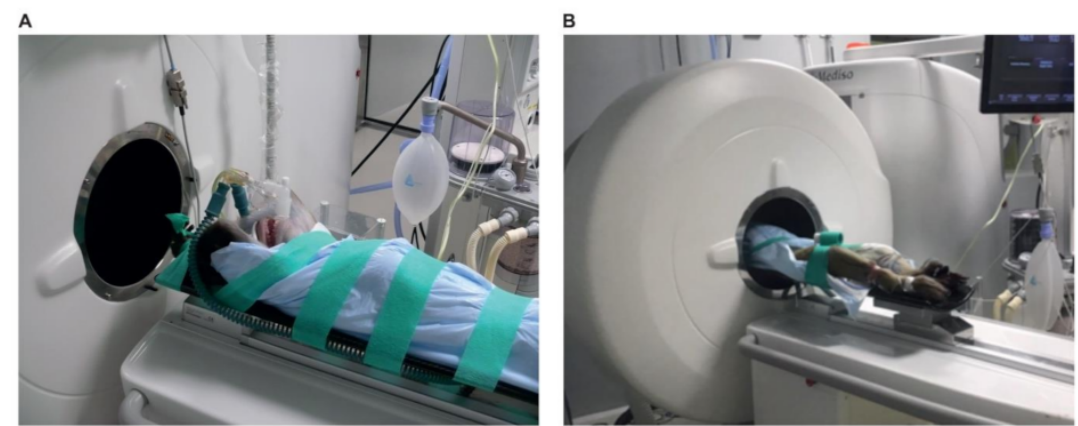
Figure 4. Visualization of the position of the animal on the scanner bed ( A ) and while scanning ( B